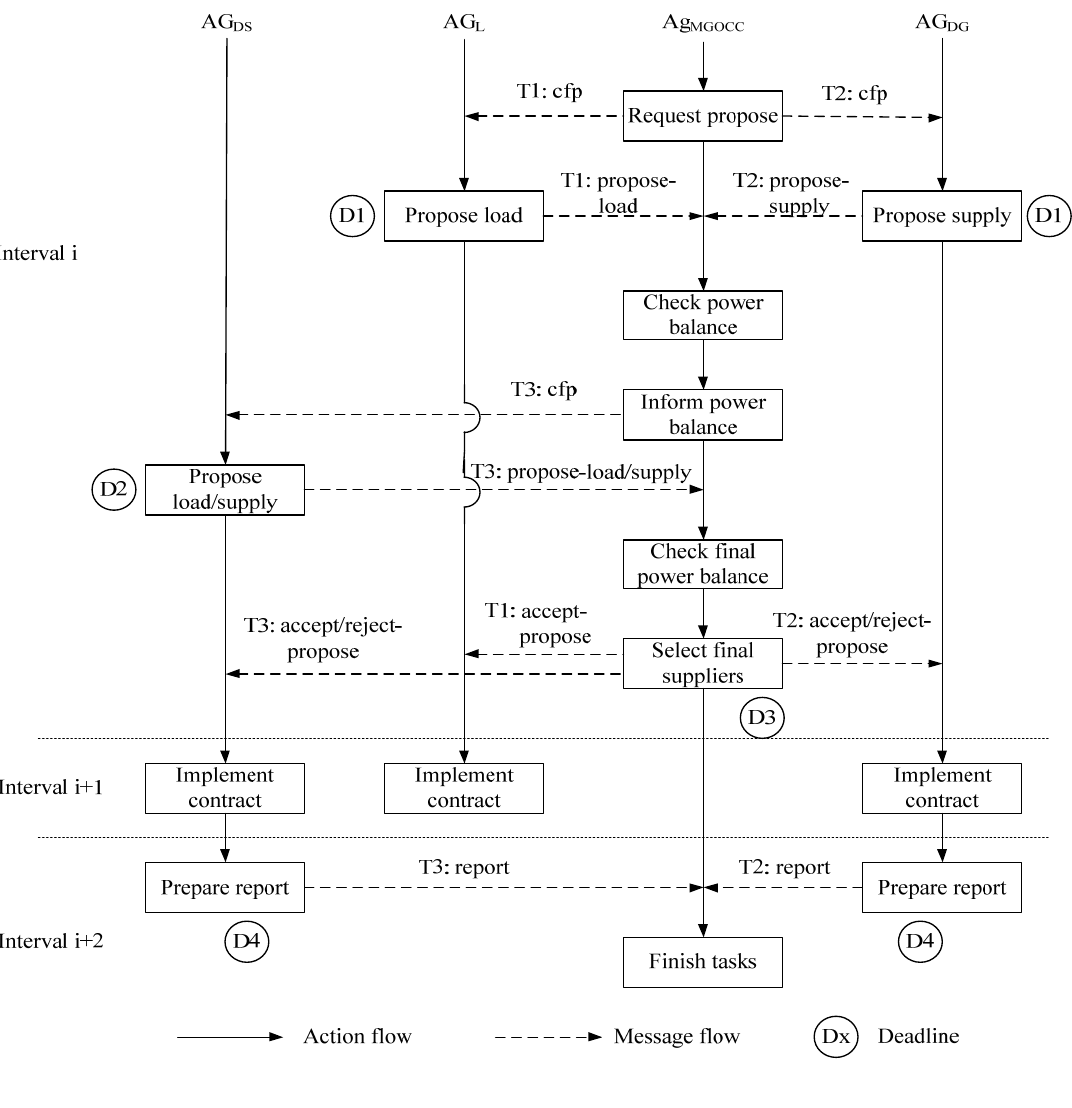
Figure 3. Workflow for microgrid